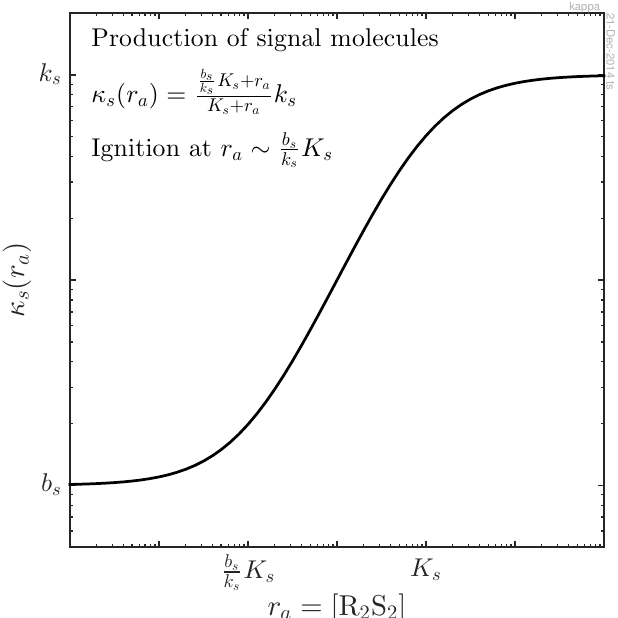
, as a function of activated regulator s